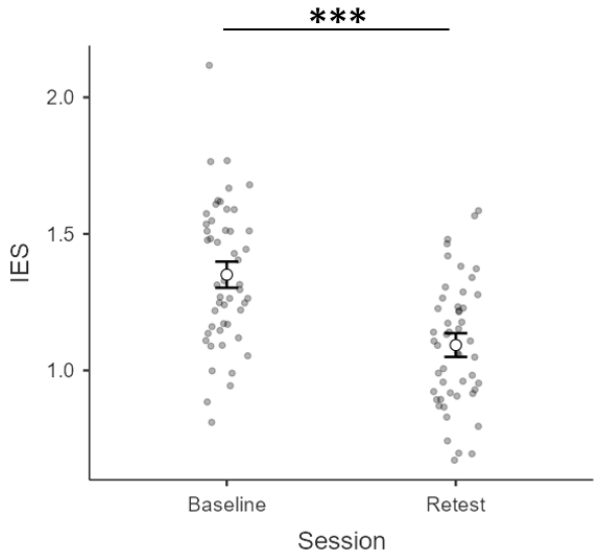
Figure 3. Estimated marginal means and error bars expressed as 95% standard errors. The graphs show side-collapsed observed scores relative to IES ( y -axis) as a function of the testing session ( x -axis): baseline (left) vs. retest (right). *** = p < 0.001.